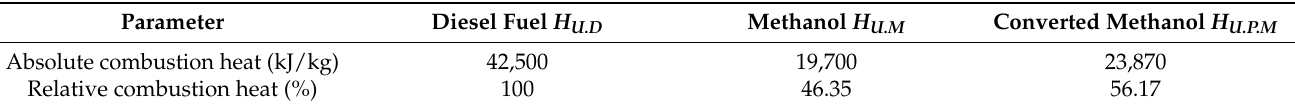
Table 2. Comparative characteristics of the combustion heat of methanol and diesel fuel.